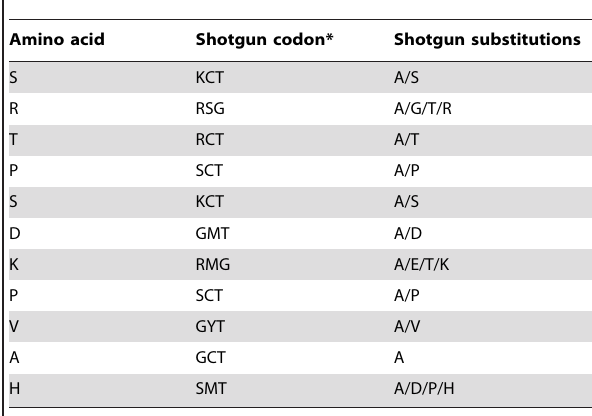
For each amino acid, the appropriate shotgun codon ideally encodes only the wild-type amino acid or alanine, but the nature of the genetic code necessitates the occurrence of 2 other amino acids for some shotgun substitutions. Single- letter amino acid and nucleotide abbreviations are used. * DNA degeneracies are represented by the IUB code (K=G/T, M=A/C, N=A/C/ G/T, R=A/G, S=G/C, W=A/T,